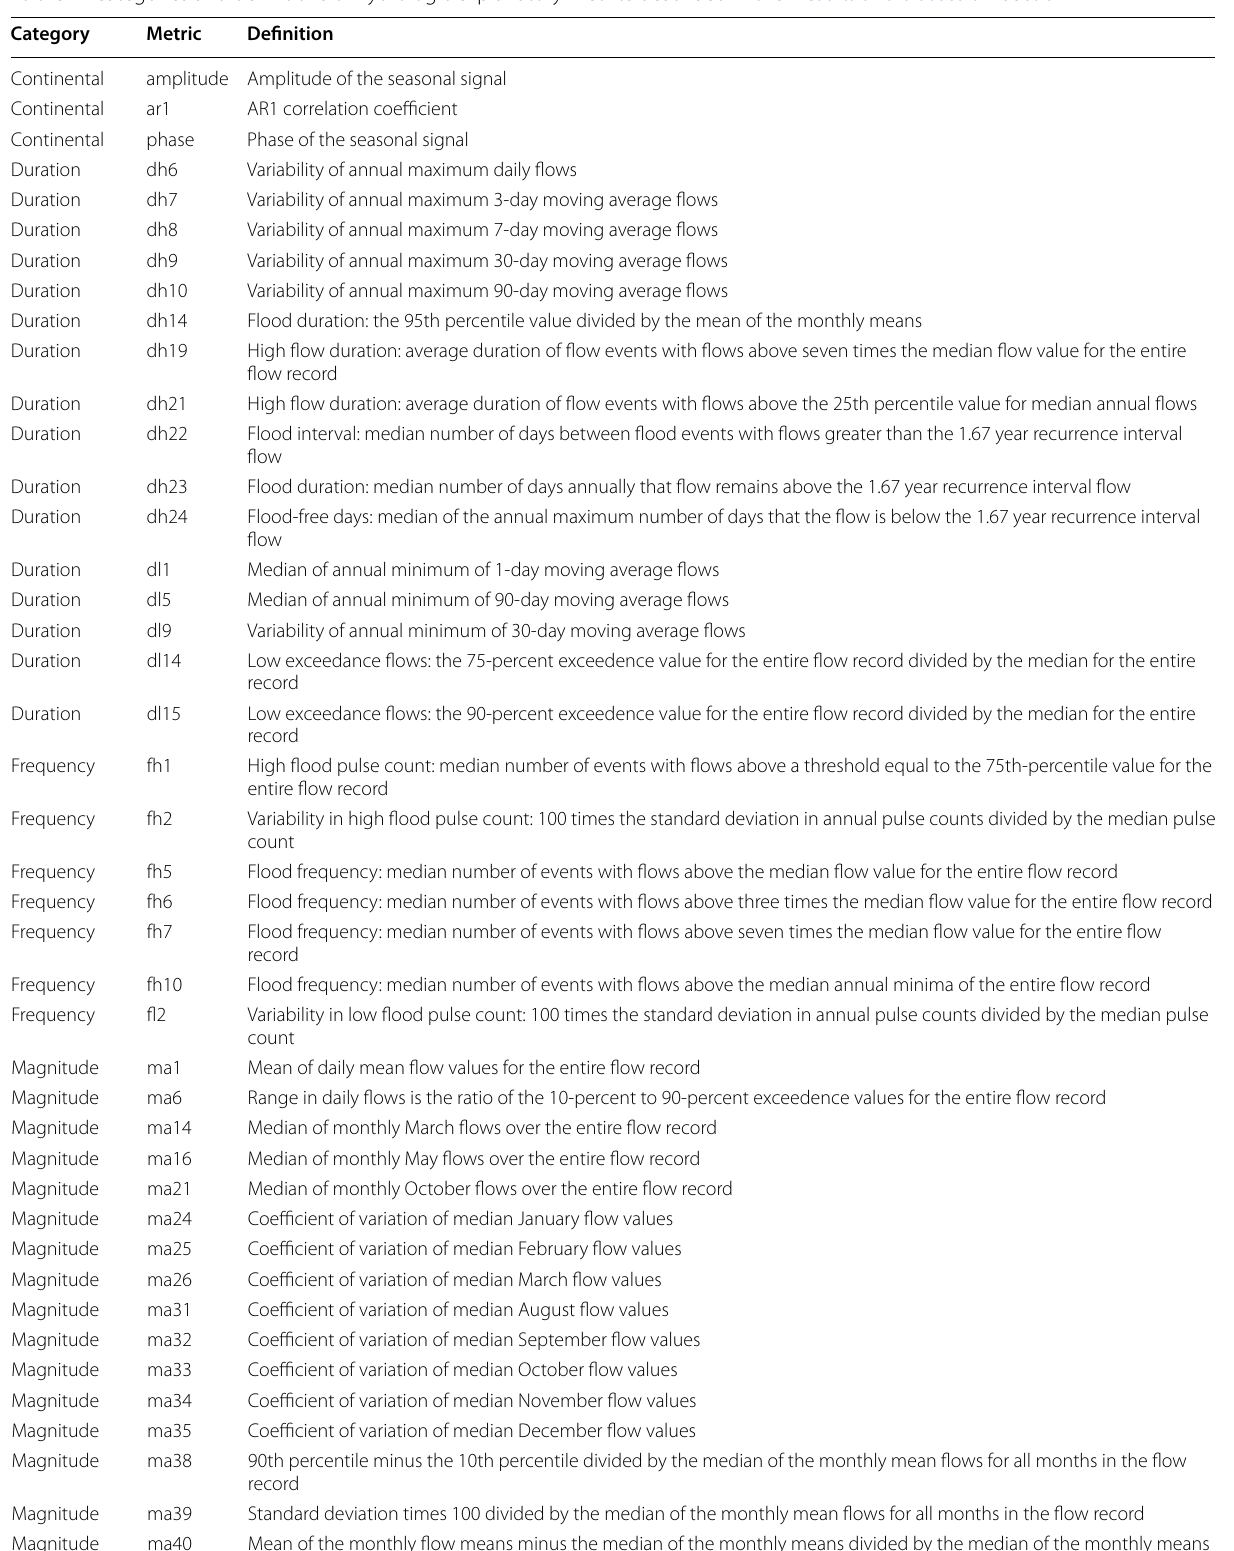
Table 2 Categories and definitions of hydrologic explanatory metrics described in the “Results and discussion” section